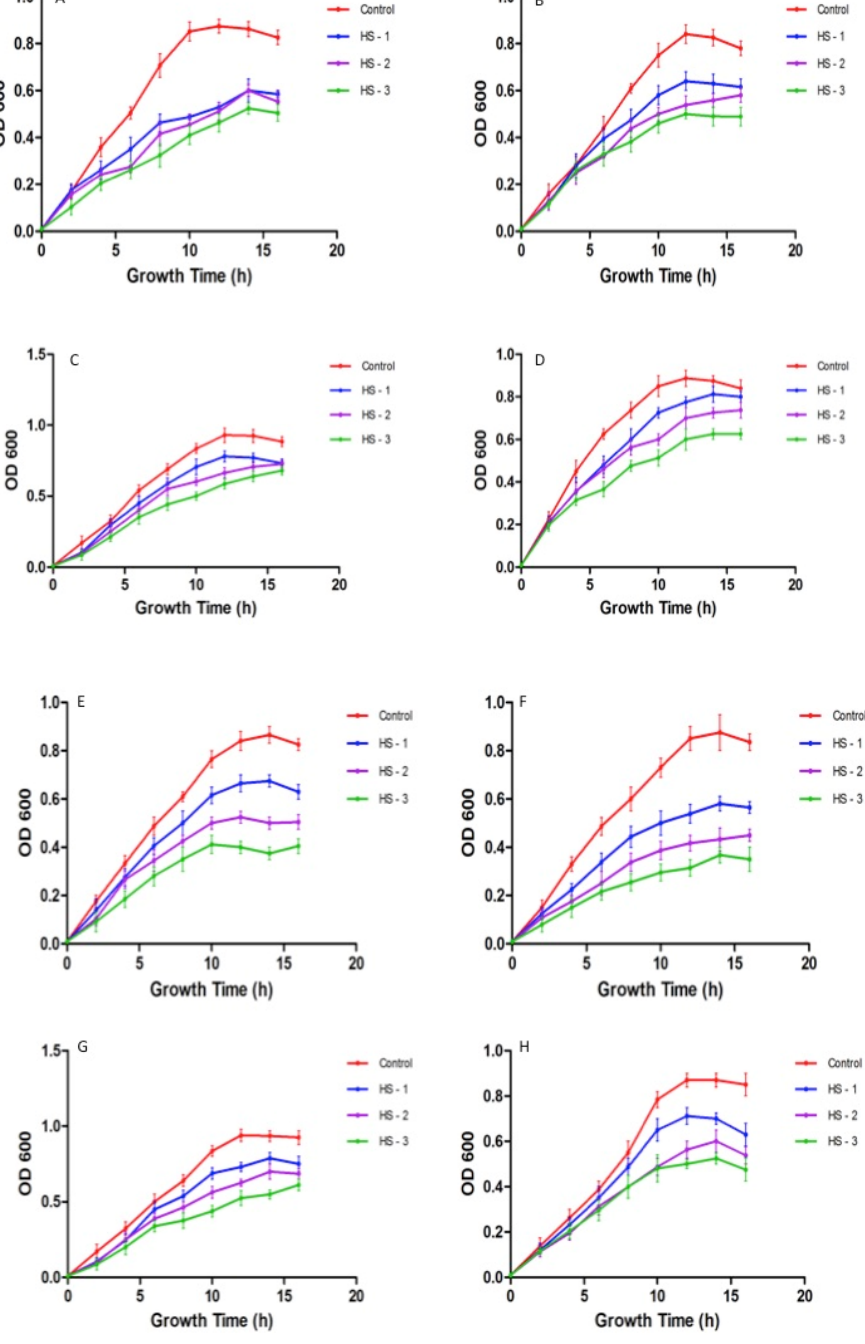
Figure 6. ( A – H ) . Effect of honey with silver nanoparticles on microbial growth. (HS-1: 20% honey with silver nanoparticles; HS-2: 40% honey with silver nanoparticles; HS-3: 80% honey with silver nanoparticles). ( A ) Pseudomonas aeruginosa; ( B ) Escherichia coli; ( C ) Klebsiella pneumoniae; ( D ) Salmonella; ( E ) Staphylococcus aureus; ( F ) Staphylococcus saprophyticus; ( G ) Streptococcus pyogenes; ( H ) Enterococcus faecalis . The growth cycle of untreated organisms served as the growth control. Optical density at 600 nm was measured at regular time intervals of 2 h.